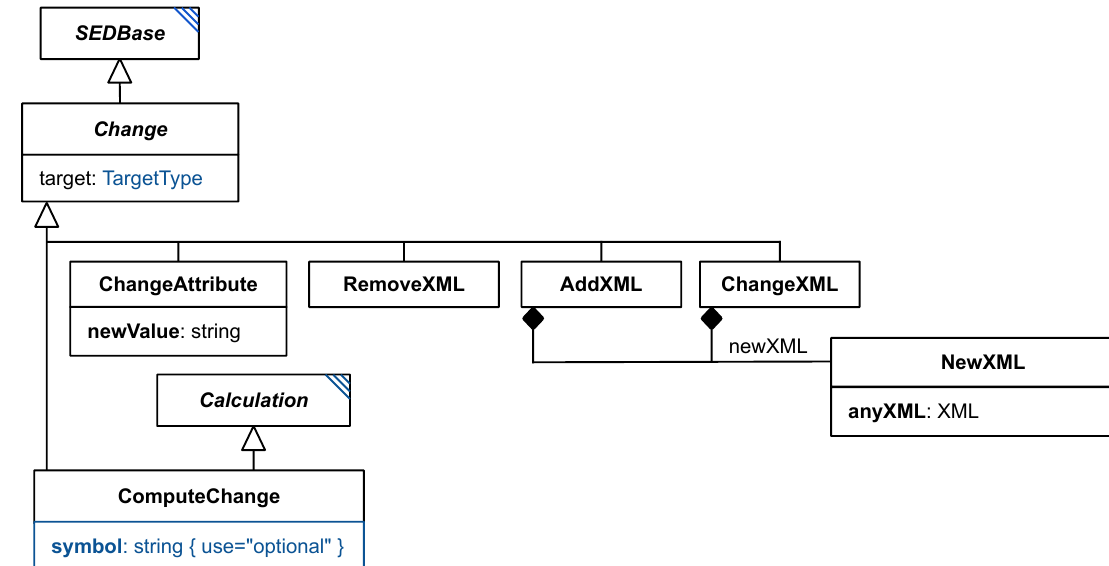
Figure 2.10: The SED-ML Change